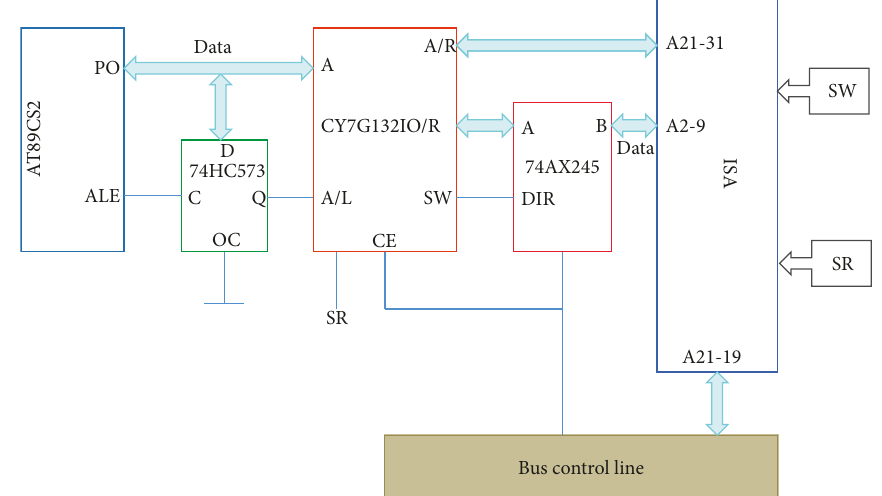
Figure 2: Diagram of sensor data flow interface.